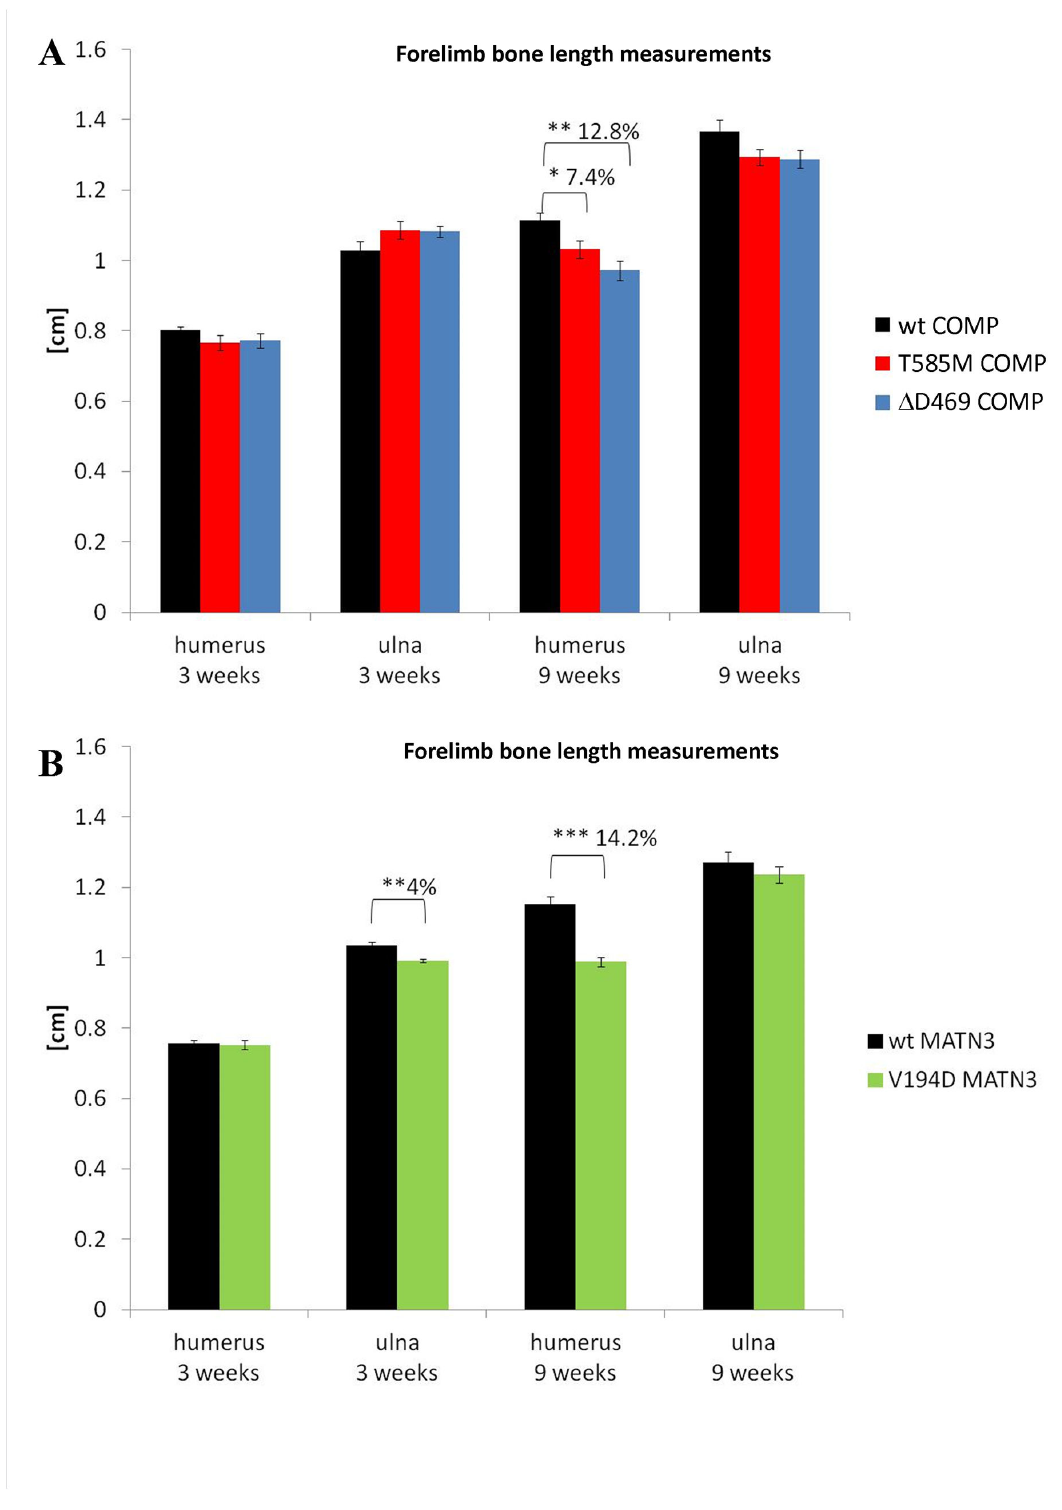
Figure 1. Bone measurements based on X-rays of 3, 6 and 9 week old mice. Humeri in COMP mutant mice ( A ) and in matrilin 3 mutant mice ( B ) were shorter than in the wild type controls. Error bars; SEM (standard error of the mean; n≥10). Key: * P<0.05, ** P<0.01, *** P<0.001. doi: 10.1371/journal.pone.0082412.g001 PLOS ONE |